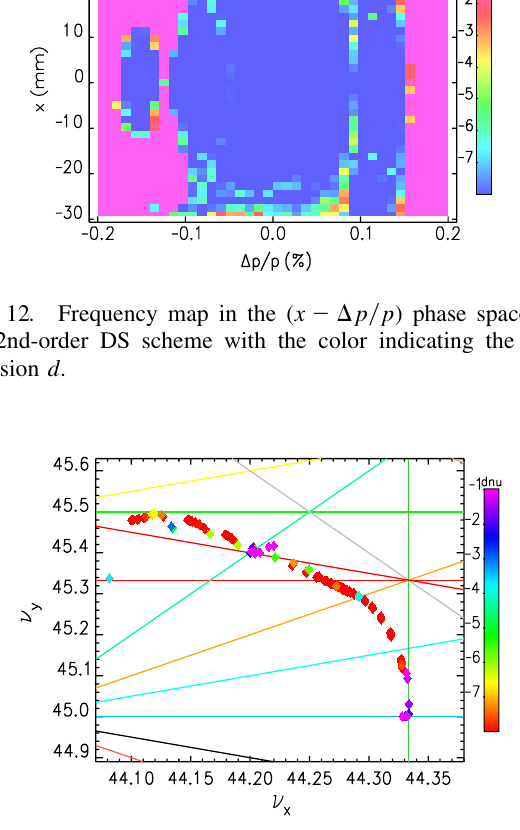
FIG. 13. Tune footprint for the 2nd-order DS scheme with the color indicating the tune diffusion d